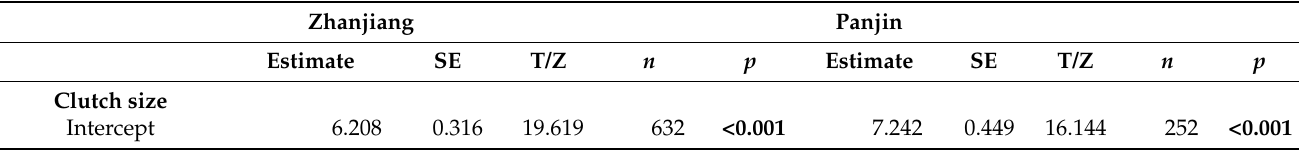
Table 2. Effects of weather conditions on the reproduction of the Barn Swallow. Estimates, standard error, T/Z values, sample size, and p values of the GLMMs are presented. For each response variable, weather conditions (temperature, precipitation) of the corresponding breeding period were analyzed (clutch size: egg-laying period; hatching success: incubation period; brood size and nestling survival: brooding period). Significant differences ( p < 0.05) are indicated by bolded